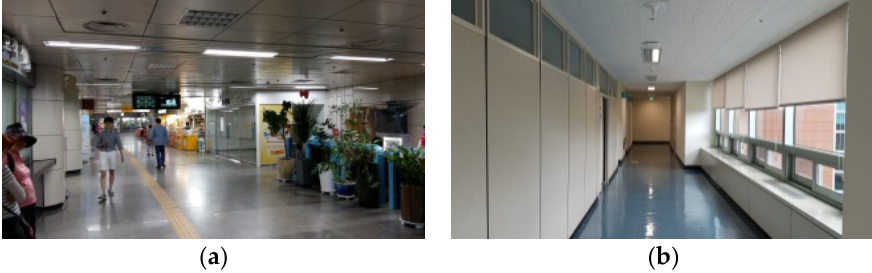
Figure 6. ( a ) An indoor Bangbae station view; and ( b ) a typical aisle in the ETRI